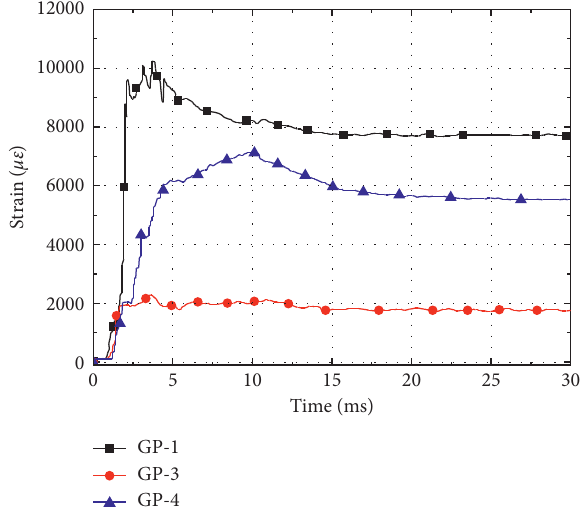
Figure 19: Strain time-history curve of ST3 collection